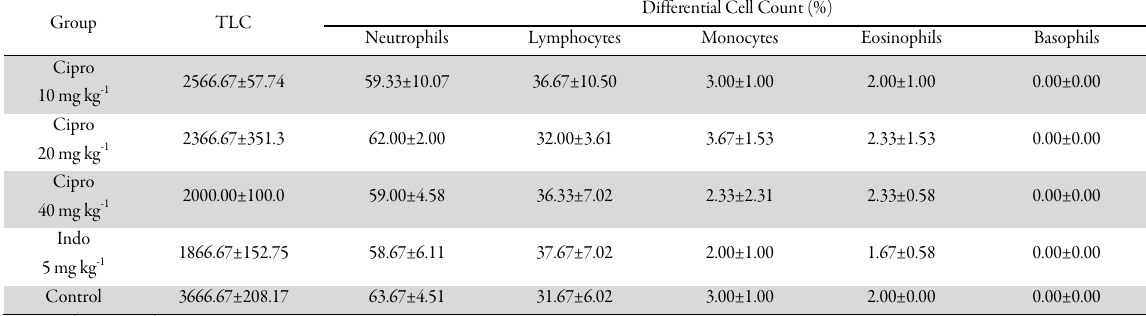
Table 1. Effect of Ciprofloxacin on agar-induced leukocyte mobilization